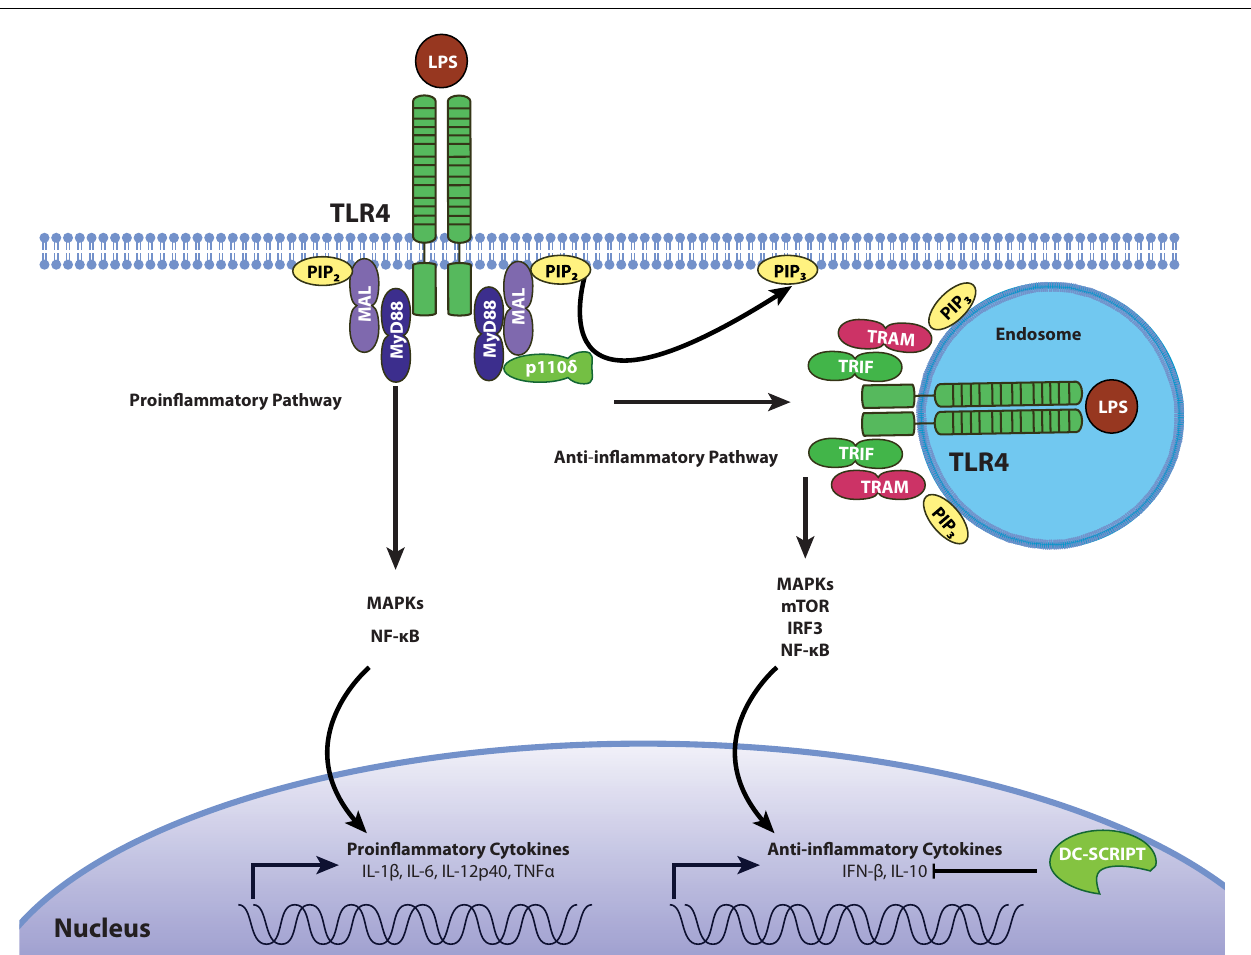
phosphorylation of PIP 2 into PIP 3 by the p110 δ isoform of PI3K causes the translocation of the receptor-ligand complex into endosomal compartments, whereTLR4 signals through the adaptorsTRIF andTRAM to induce the secretion of IL-10 and type I IFNs through MAP kinases, NF- κ B, and IRF3.This mechanistic framework is likely operational in macrophages but not in DCs depending on expression of DC-SCRIPT, a transcription factor which suppresses IL-10